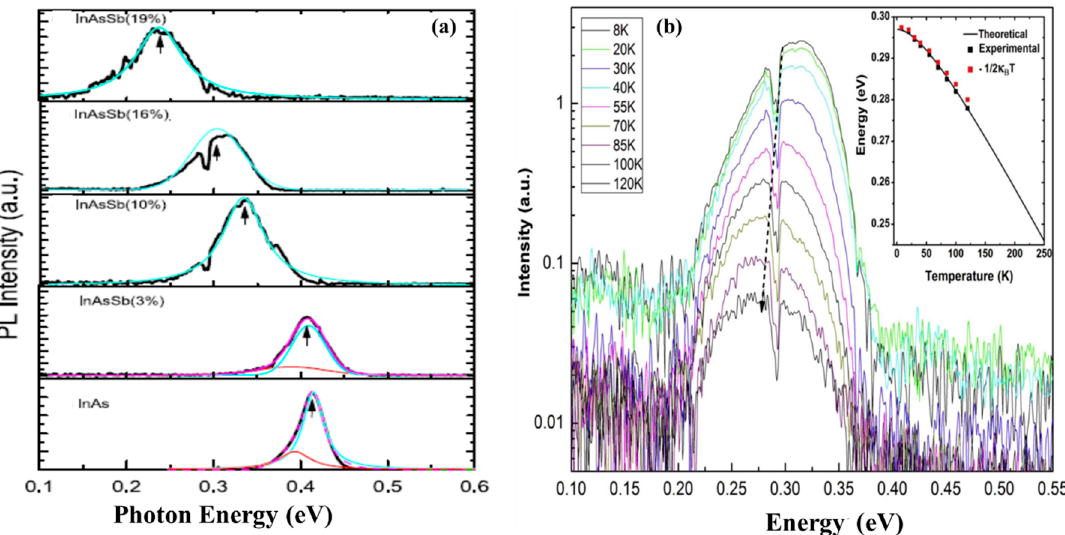
Figure 8. ( a ) The evolution of 10 K PL of InAs NWs and InAsSb NWs with an Sb composition of 3%, 10%, 16% and 19%. The peaks in colors show the decomposed emissions. ( b ) The photoluminescence of InAs0.84Sb0.16 NWs measured at various temperatures. The inset is the peak energy E p , the energy of E g– k B T / 2, and the theoretical bandgap energy. Reproduced with permission from [87]; Copyright 2017, IOP publishing Ltd.